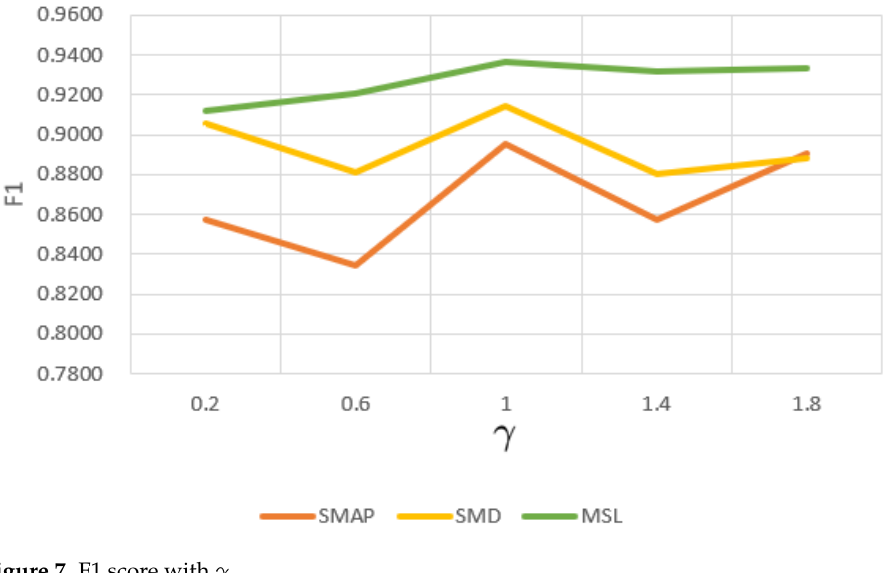
Figure 7. F1 score with γ